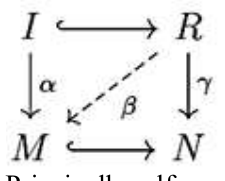
Diagram 11: Principally self-pure